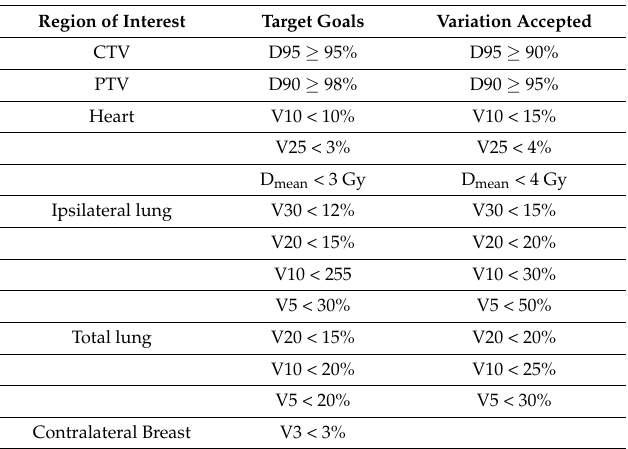
Table 1. Dose objectives used for plan evaluation. Region of